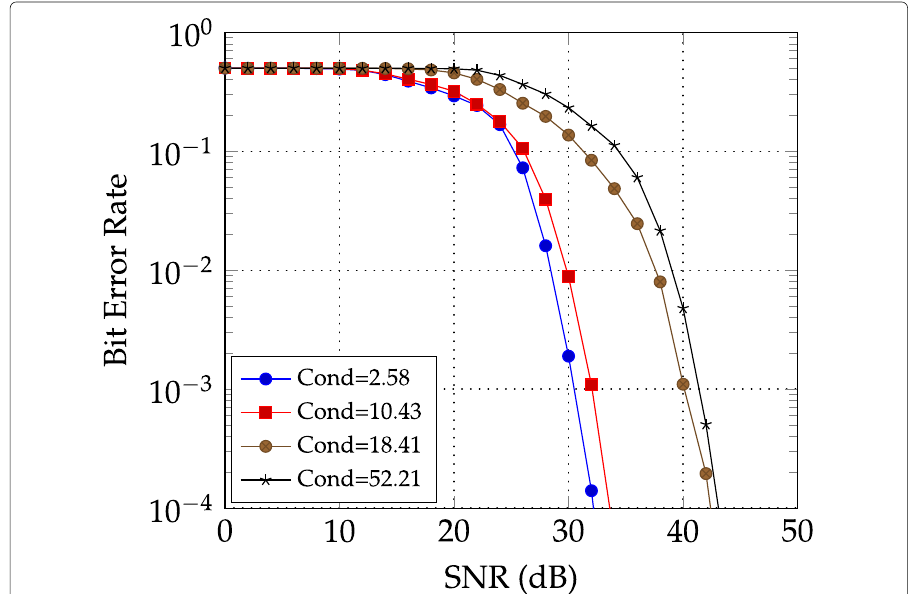
Fig. 4 Effect of the postcoder’s condition number on the BER vs SNR—5 × 5 MIMO